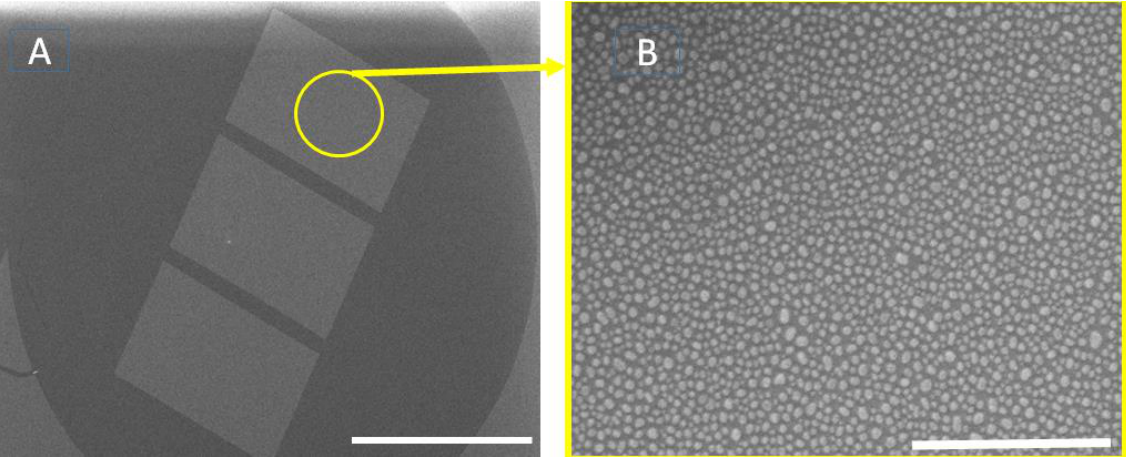
Figure 2. SEM images of the patterns of Tri-Slot TEM grid on coverslips after annealing on a hot plate ( A ) scale — 1 mm and the morphology of AuNPs ( B ) scale — 500 nm.